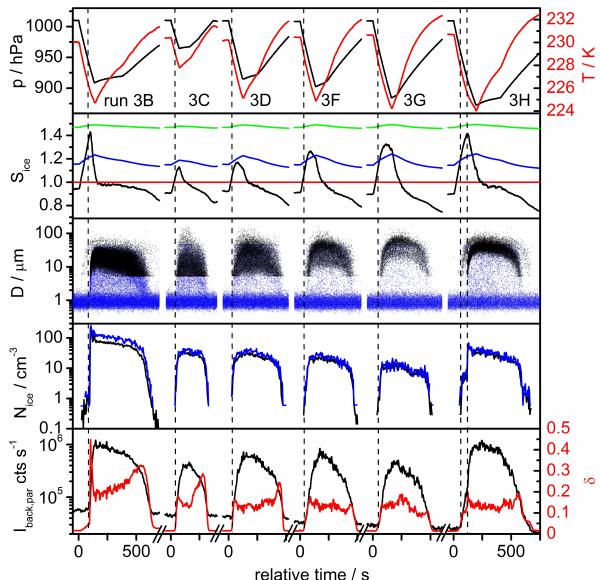
Fig. 11. Time series of various AIDA records during expansion runs 3H, 3I, 3J, and 3K with raffinose. The individual panels contain the same measurements as in Fig.